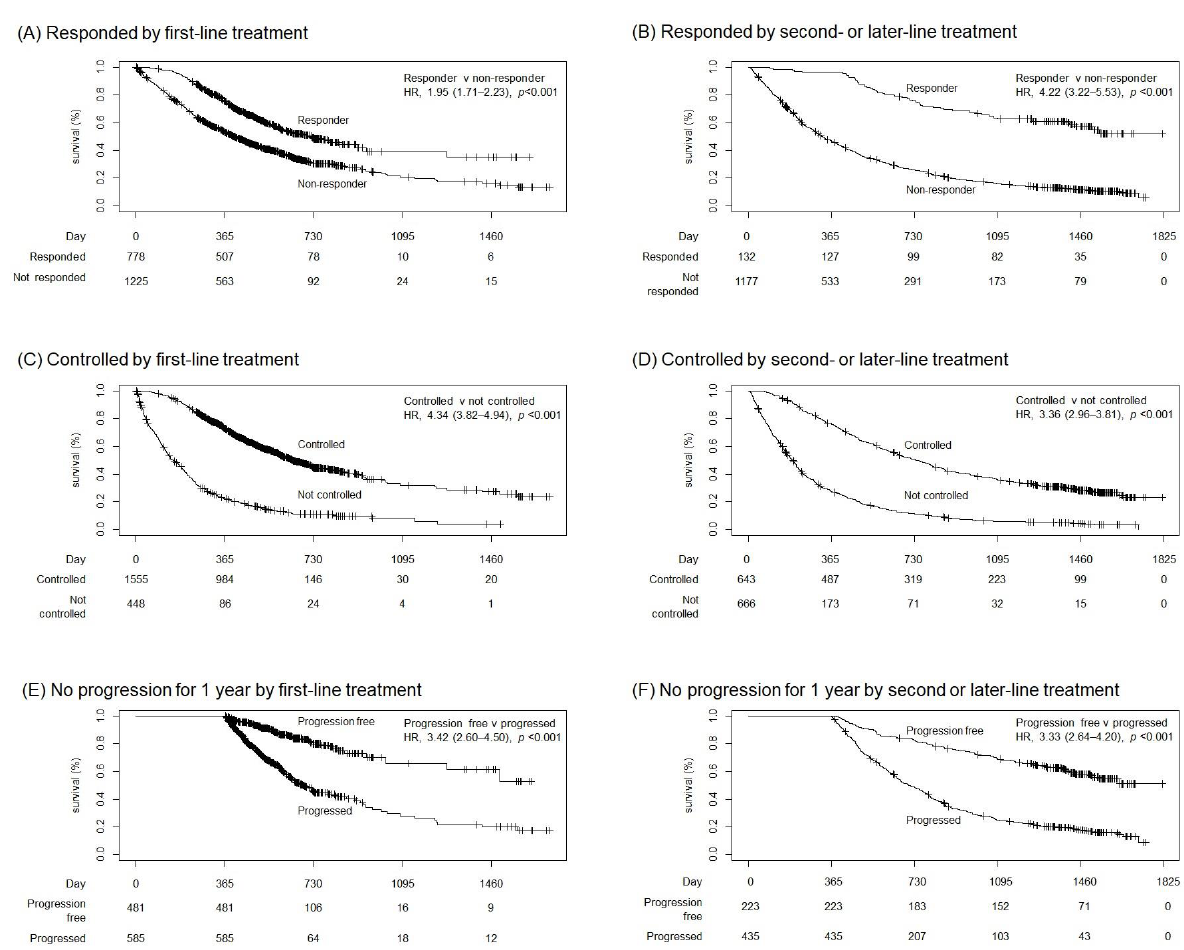
Figure 1. Kaplan – Meier estimates of overall survival based on response evaluation after two cycles and based on 1-year progression-free survival. Responded, complete response, and partial response; controlled, complete response, partial response, and disease control. HR, hazard ratio; brackets, 95% confidence interval.